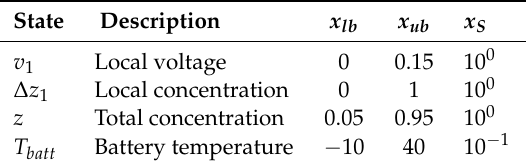
Table 4. States upper and lower bounds as well as scalings.